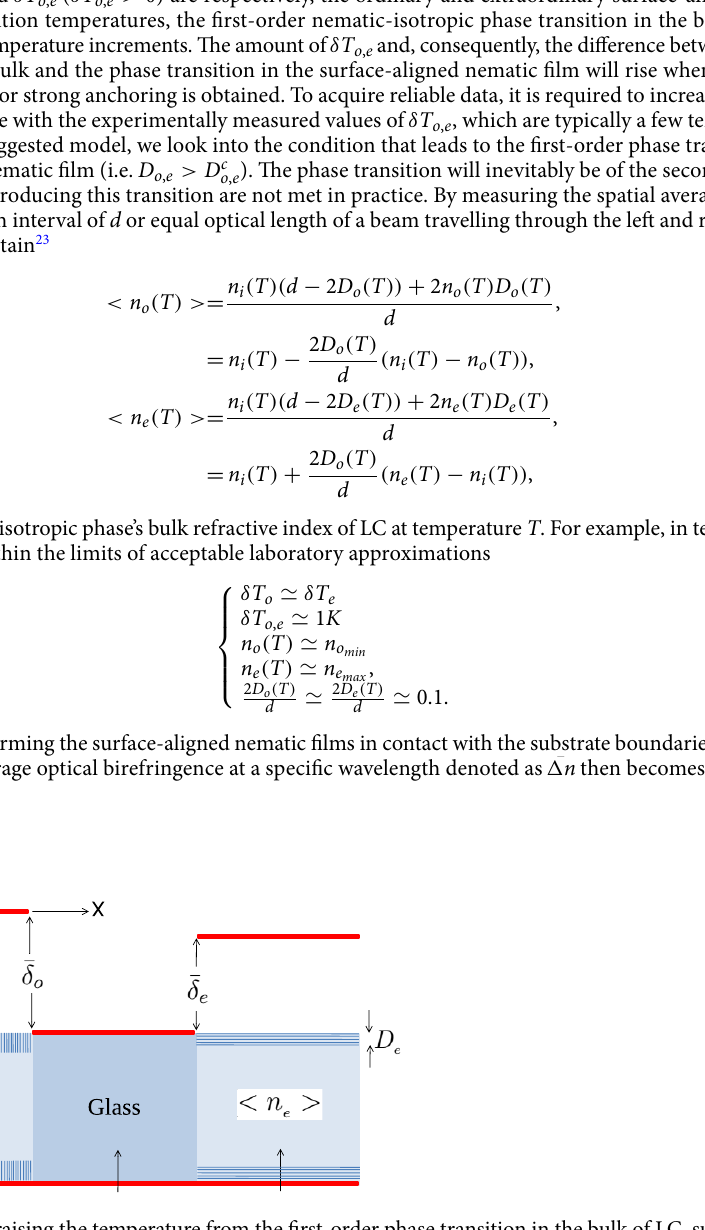
Figure 11. After raising the temperature from the first-order phase transition in the bulk of LC, surface-aligned nematic films with thicknesses D o and D e attached to the substrates, respectively, form on the left and right sides of the LC cell, causing the average refractive indices to be < n o > and < n e > in these two